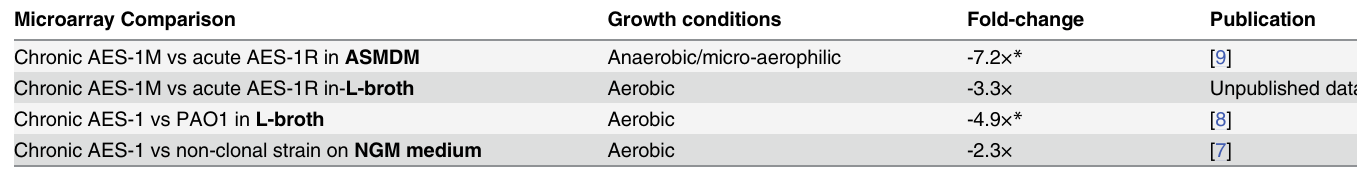
Table 1. Differential expression of hmgA by P . aeruginosa AES-1 by microarray analyses (all experiments conducted in biological duplicate). Microarray